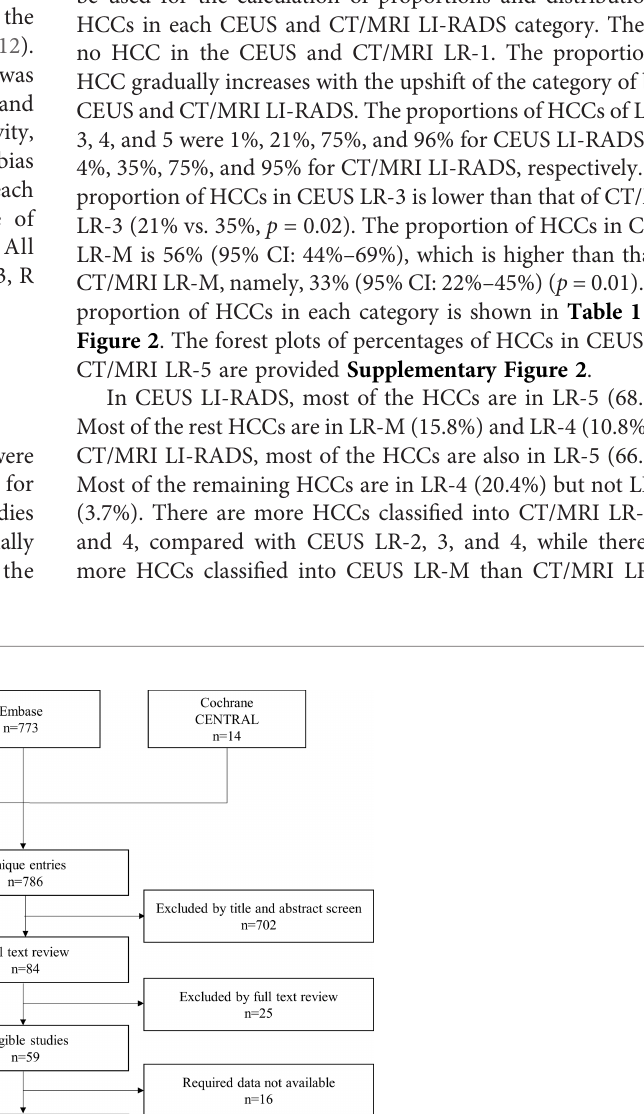
FIGURE 1 | Flow diagram of the selection of